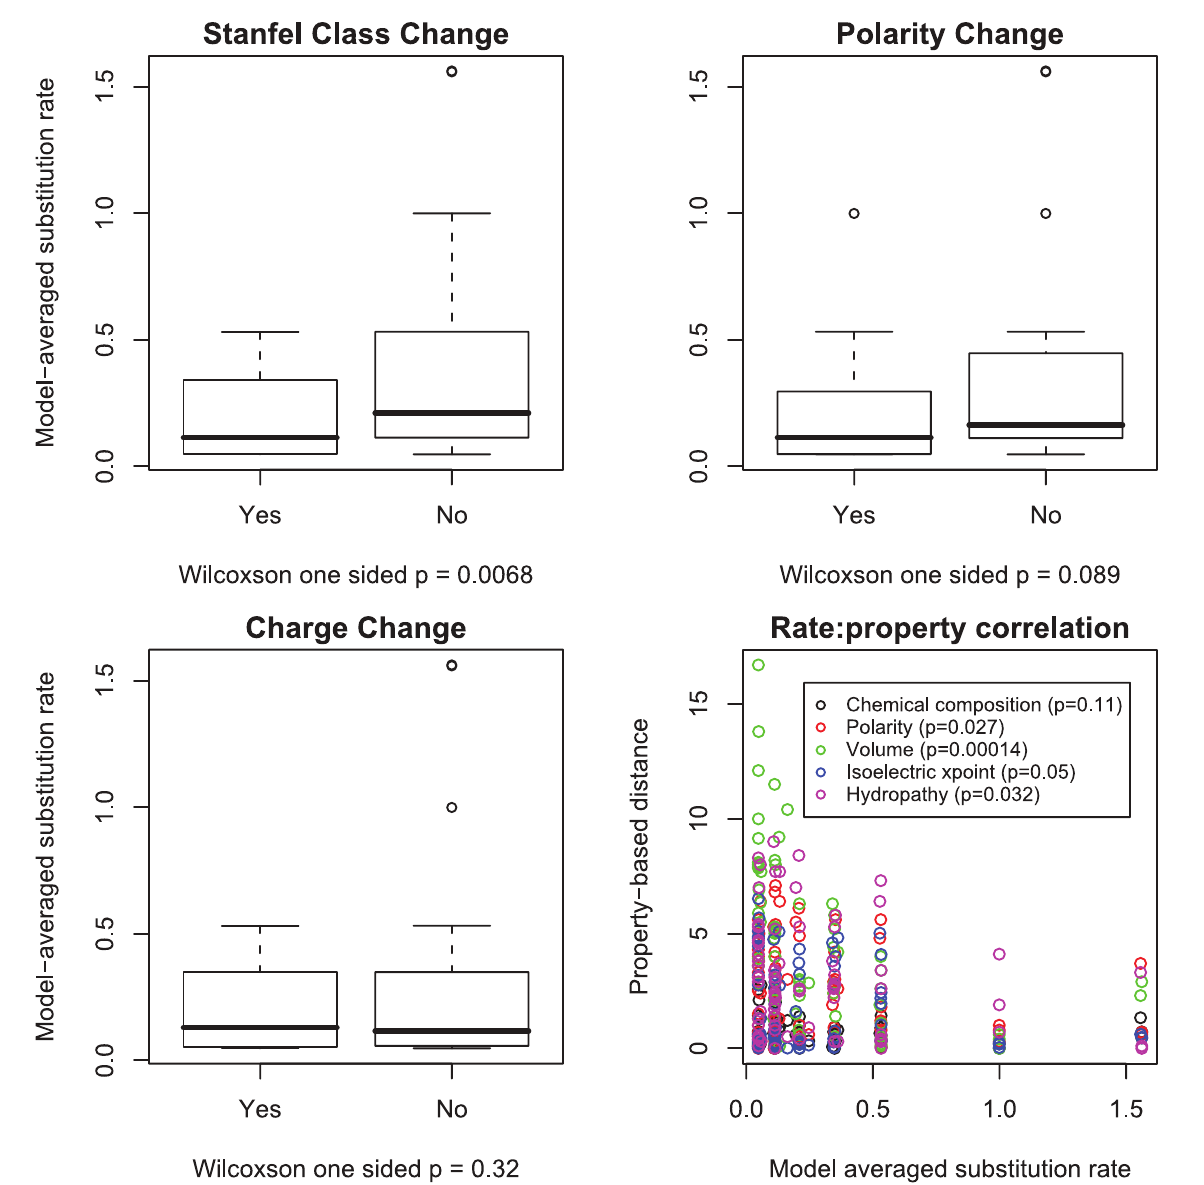
Figure 6. Correlations of lower substitution rates and property preservation in the HIV-1 group M pol alignment. Model-averaged GA r rates were stratified by whether or not they involved a change in polarity, charge or Stanfel class, the medians of two rate distributions were compared using a one sided Wilcoxon rank-sum test. We further correlated the magnitude of substitution rates with one of five property-based distances between the corresponding residues (defined in [18]) using a one-sided (negative correlation) Pearson product-moment correlation